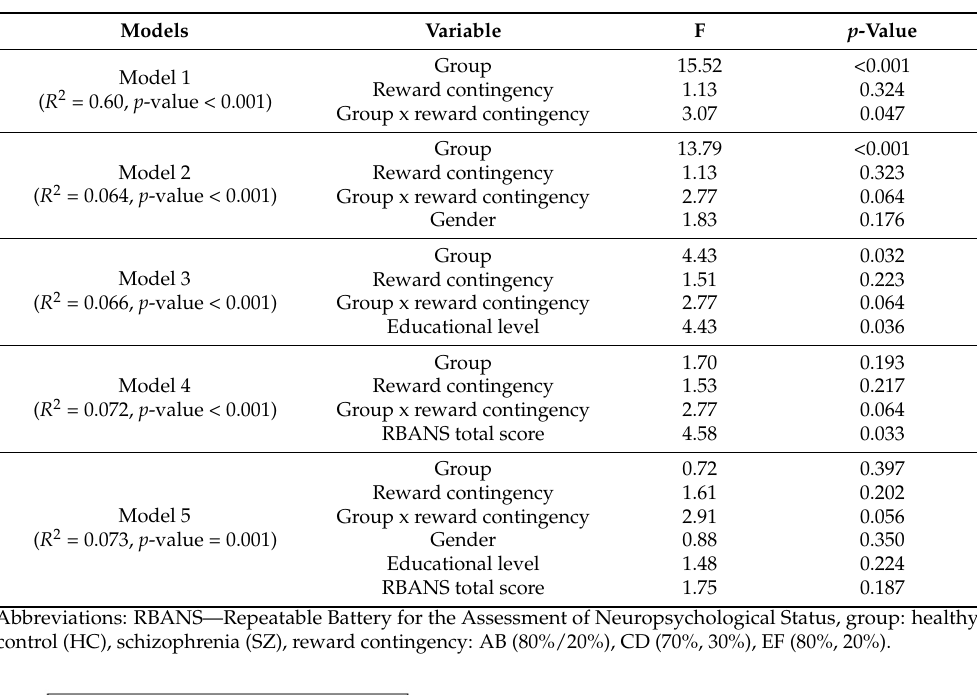
Table 2. Acquisition of probabilistic contingencies for AB, CD, and EF conditions.